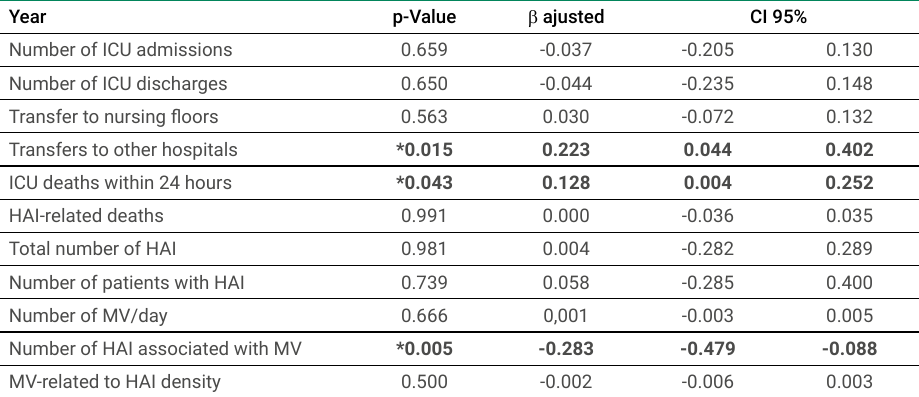
Table 2. Multivariate